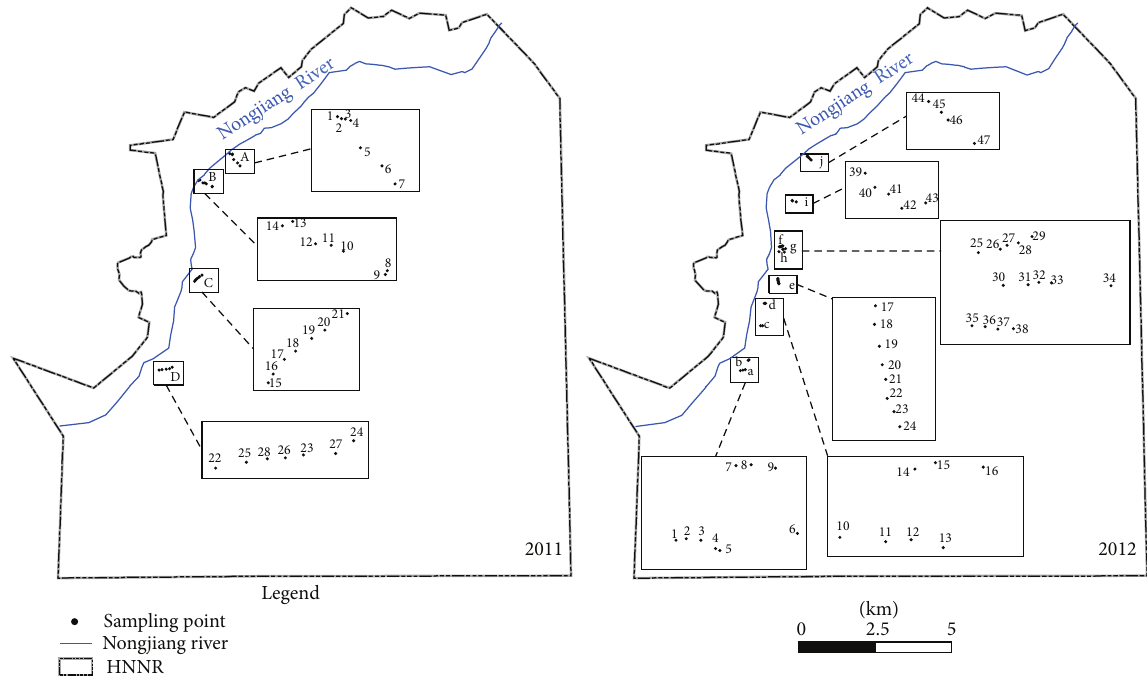
Figure 2: Location of sampling spots.